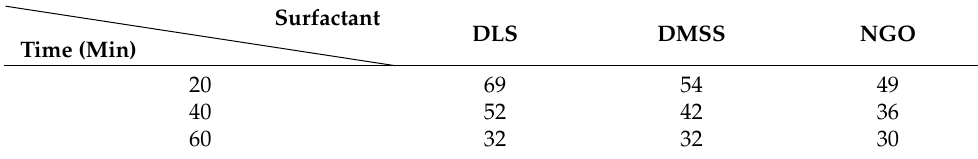
Table 6. Comparison of different surfactants for reducing interfacial tension (mN · m − 1 ).